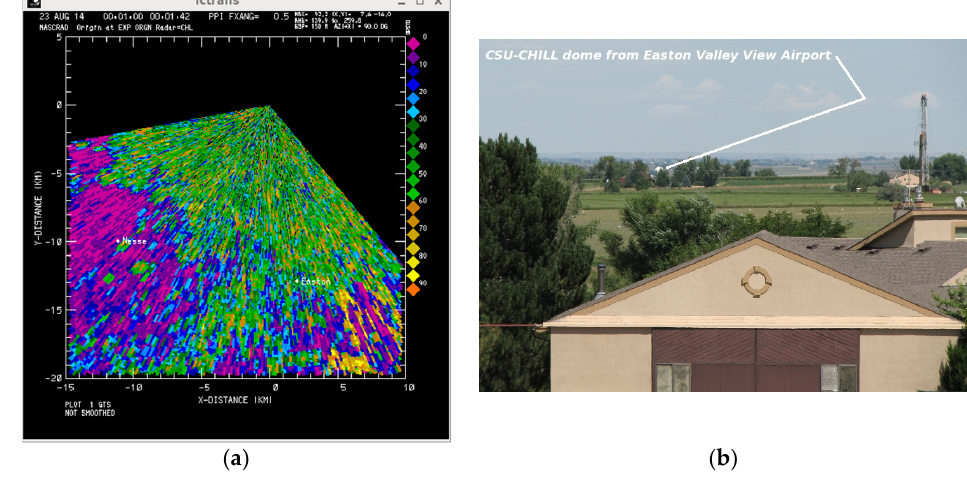
Figure 13. ( a ) Two best candidate sites for the MASCRAD project: the “Nesse site” and the “Easton site”, at a range of 14.88 km and 12.92 km, respectively, from the CHILL Radar; ( b ) From the Easton Valley View Airport, one can see the CHILL Radar radome.